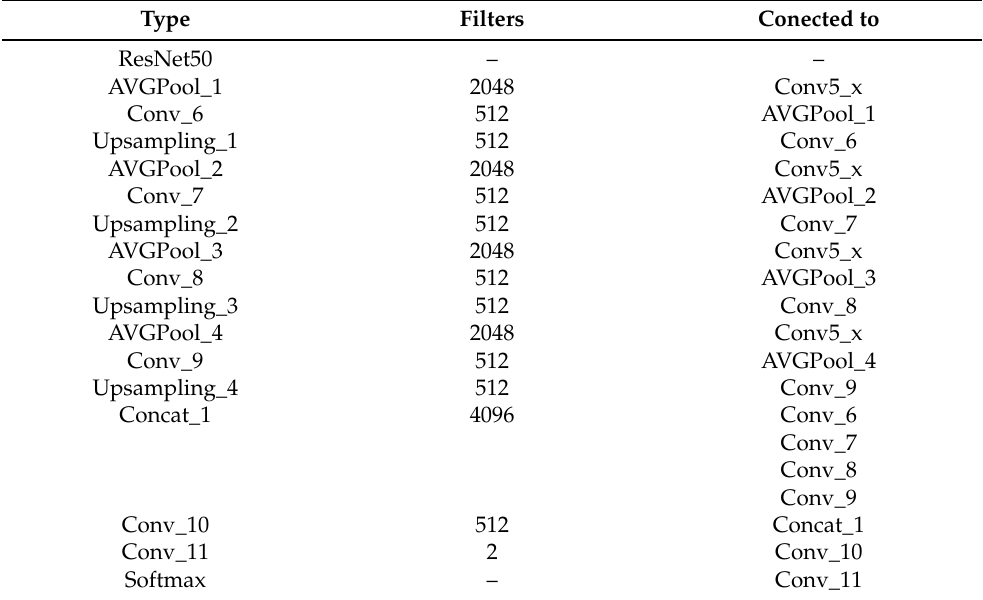
Figure 11. Architecture of the ResNet50+PSPNet. Table 5. Layer description of the